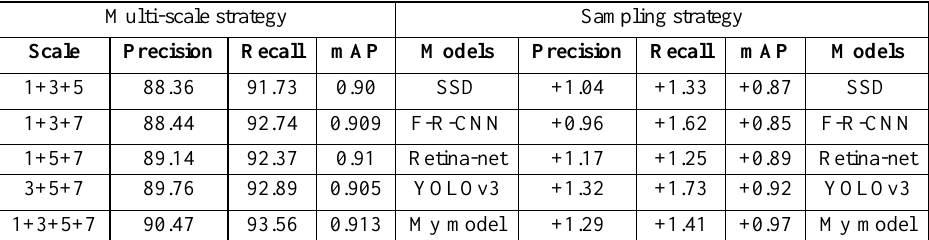
Table 3. Experimental results for multi-scale strategy and sampling